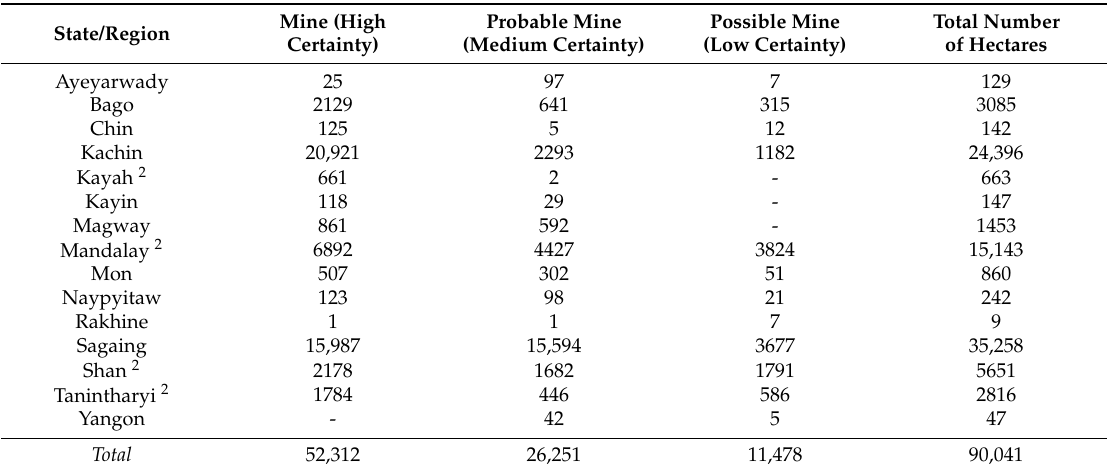
Table 3. 2015 mining area identified in this study (in hectares) by state/region and certainty level 1 . State/Region